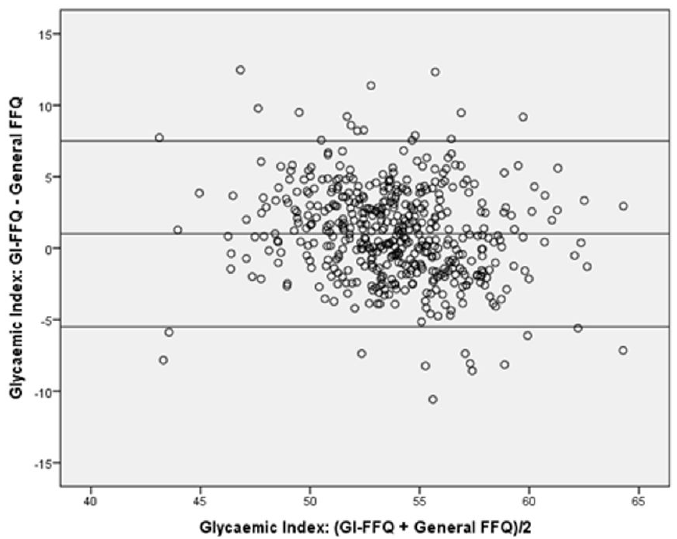
Figure 1. Bland-Altman plot for glycaemic index showing the relative validity of the GI-FFQ versus the general-FFQ. Middle line indicates the mean; upper and lower lines indicate borders based on mean ± SD × 1.96 (i.e., 1.0+/ − 6.5).